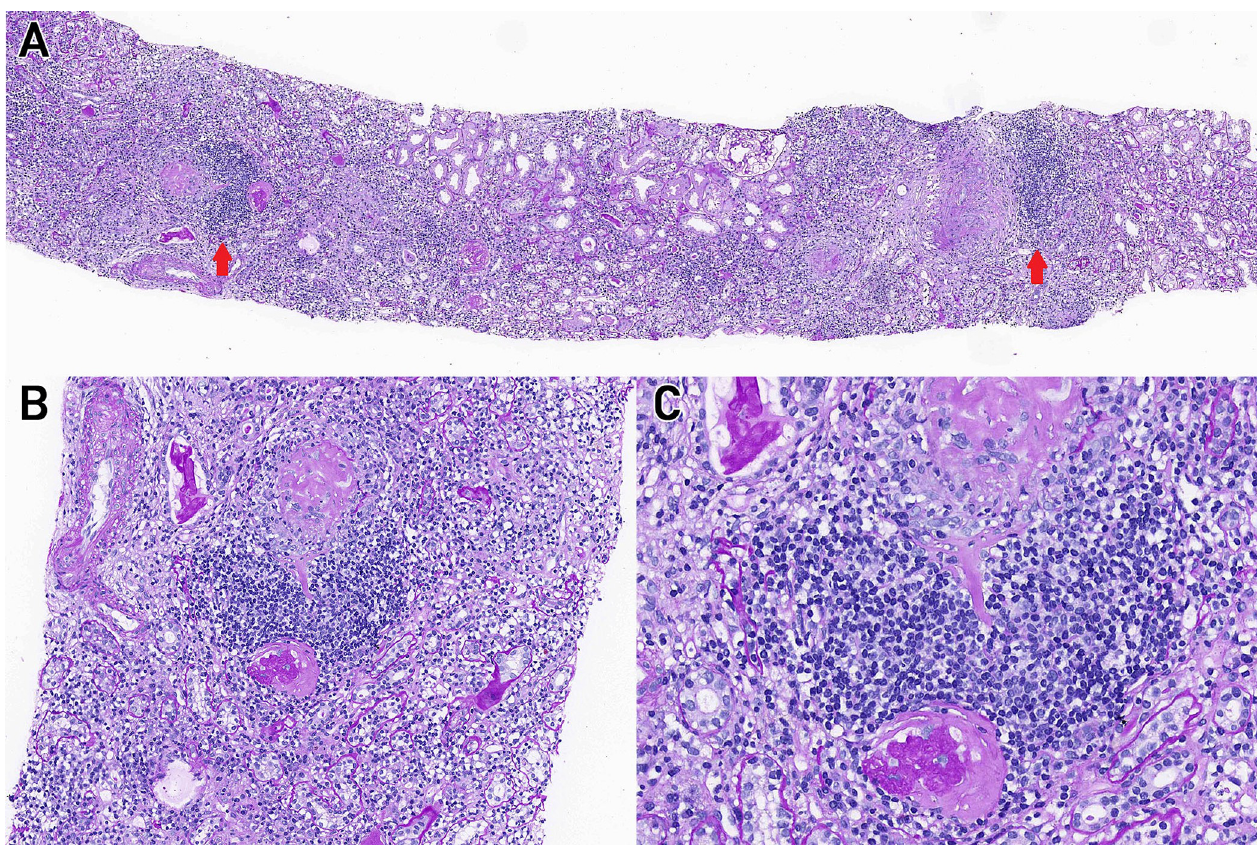
Fig 1. Tertiary lymphoid organ formation in renal parenchyma. PAS staining reveals nodular lymphoid aggregates. (A) Arrows indicate tertiary lymphoid organ formation. Original magnification × 50. (B) Original magnification × 200. (C) Original magnification × 400. Abbreviation: PAS, periodic acid-Schiff.